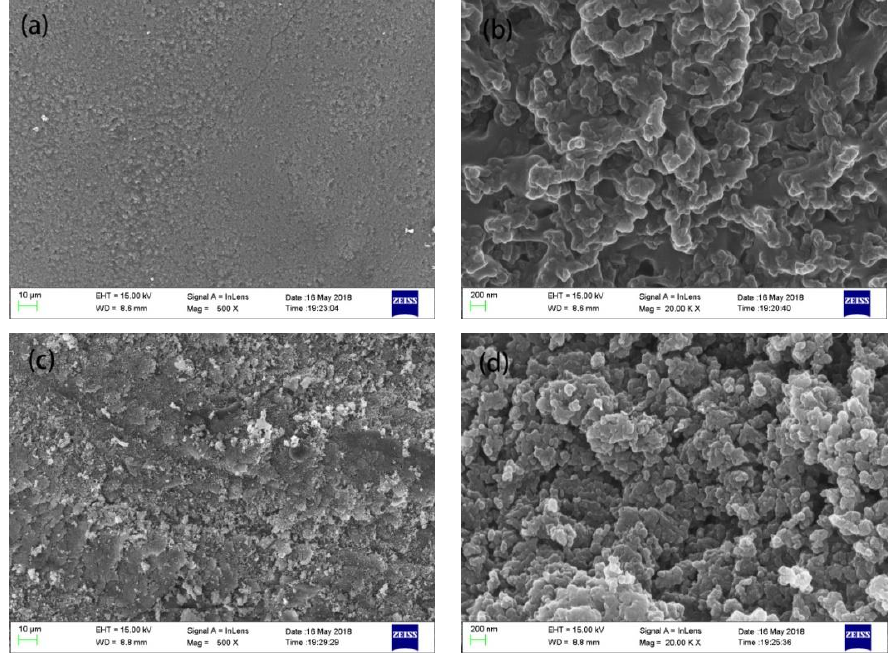
Figure 5. SEM images of the superhydrophobic bulk sample under different magnifications. ( a ): before polishing, 500×; ( b ): before polishing, 20,000×; ( c ): after polishing, 500×; ( d ): after polishing, 20,000×.